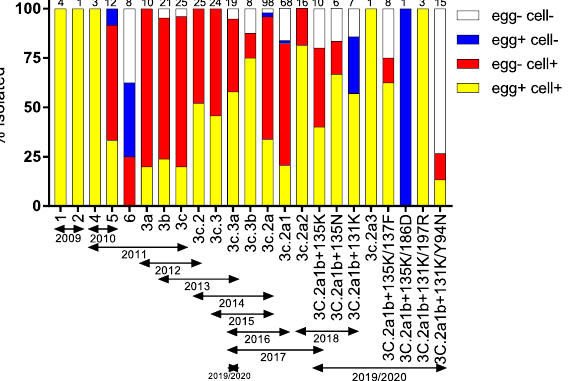
Fig. 3 Isolate rates of A(H3N2) viruses tested in cells and eggs by clade. Numbers at the top of the bars indicate the number of viruses attempted in each clade. Virus clades were determined by sequencing the HA